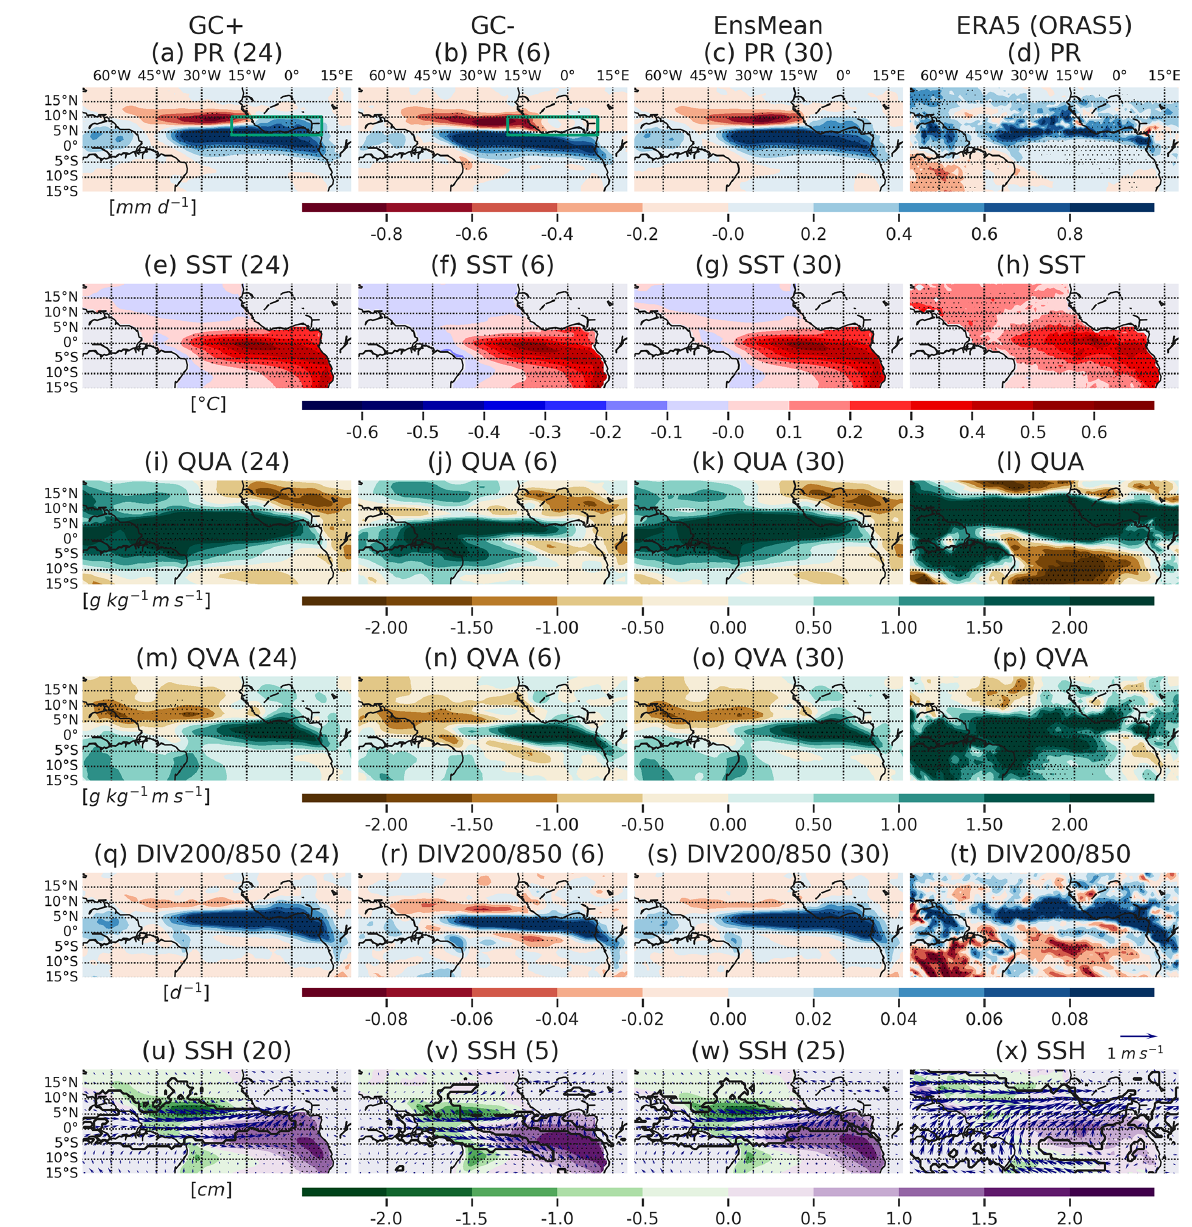
Figure 6. Regression maps of the JAS rainfall (a–d) , SST (e–h) , 850hPa zonal moisture flux (i–l) , 850hPa meridional moisture flux (m– p) , horizontal wind divergence difference between 200 and 850hPa (q–t) , and sea surface height (u–x) anomalies associated with the standardized JAS ATL3 SST index over the 1985–2014 period. Results for the GC + , GC − and EnsMean categories are displayed, and the number of models in each category is indicated in parentheses. GC + (GC − ) is a group of models with a positive (negative) sign-dependent average of the rainfall associated with the Atlantic Niño over the Guinea Coast (green boxes in a and b ). Results for the reanalyses are displayed in the rightmost column, and stippling represents significant regressions at 95% level. Stippling in the other maps indicates areas where the regression coefficients are significant at 95% confidence level for at least 50% of the models in each group, and where more than 80% of the models agree on the sign of the regression coefficient. In (u) – (x) , the JAS 850hPa horizontal wind related to the standardized JAS ATL3 SST index is superimposed on the SSH pattern, and contours represent areas where at least the zonal or the meridional component of the wind is